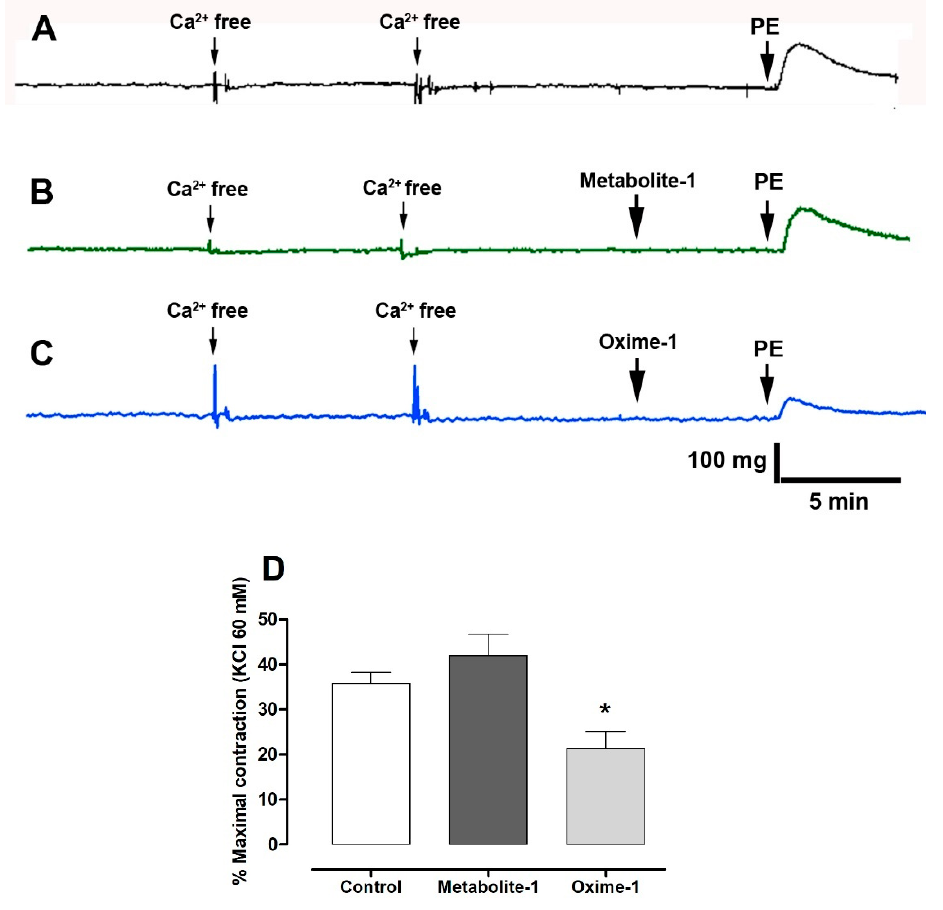
Figure 8. Effect of metabolite–1 and oxime–1 on the contractile response to PE in Ca 2+ -free medium ( A ). Intact aortic rings were used as a control ( A ), or pre-incubated with 10 − 5 M of metabolite–1 ( B ) or oxime–1 ( C ) for 20 min, and then 10 − 7 M PE was added in the Ca 2+ -free medium. Data are presented as the average standard error of the mean (SEM) of 4 independent experiments. * p < 0.05 versus control ( D ).